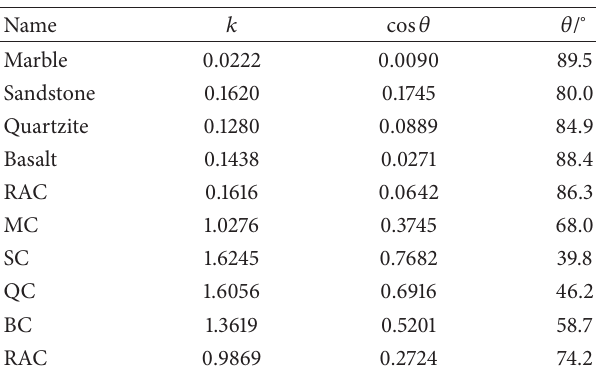
Figure 3: Wettability curve of different coarse aggregates and con- cretes. Table 5: Contact angle of different coarse aggregates and